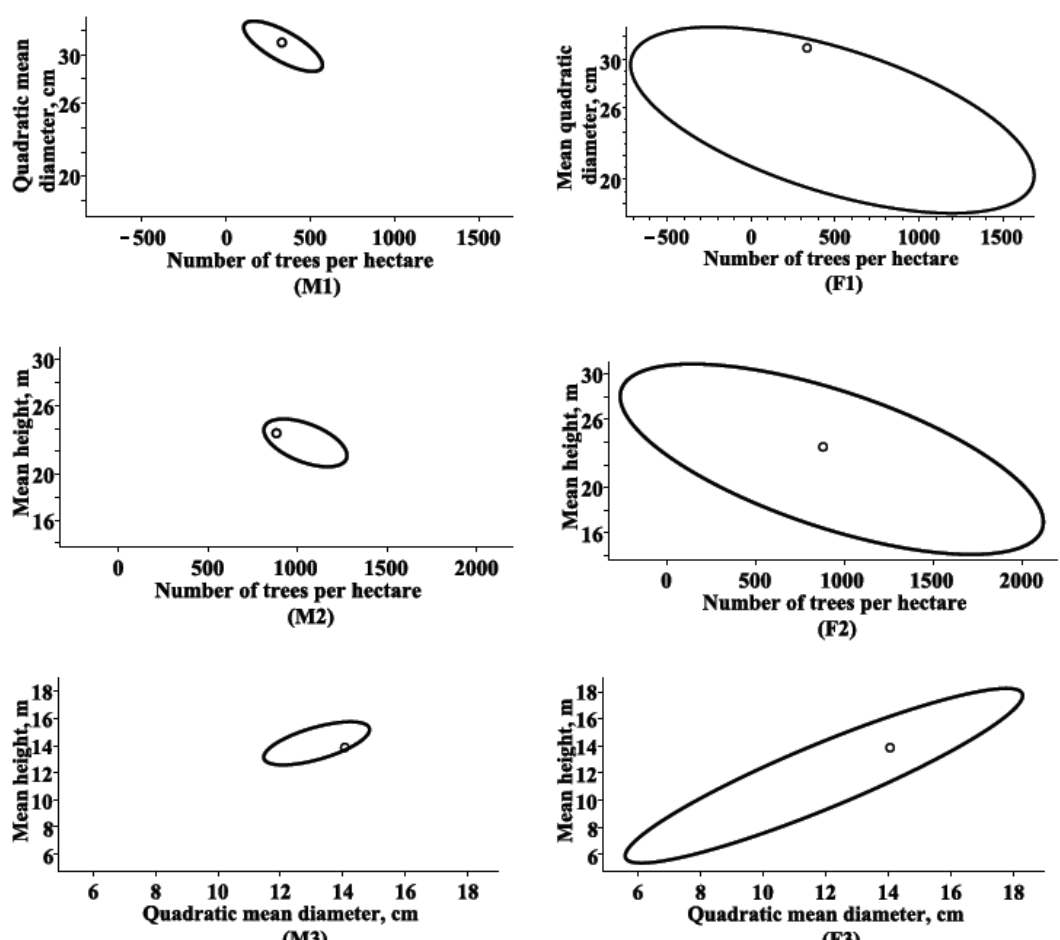
Figure 3. The 95% confidence regions with the observed data point for three randomly selected: ( M1– M3 ) mixed effects scenario; ( F1-F3 ) fixed effects scenario; ( M1, F1 ) the first stand, quadratic mean diameter and number of trees per hectare; ( M2, F2 ) the second stand, mean height and number of trees per hectare; ( M3, F3 ) the third stand, mean height, and quadratic mean diameter.